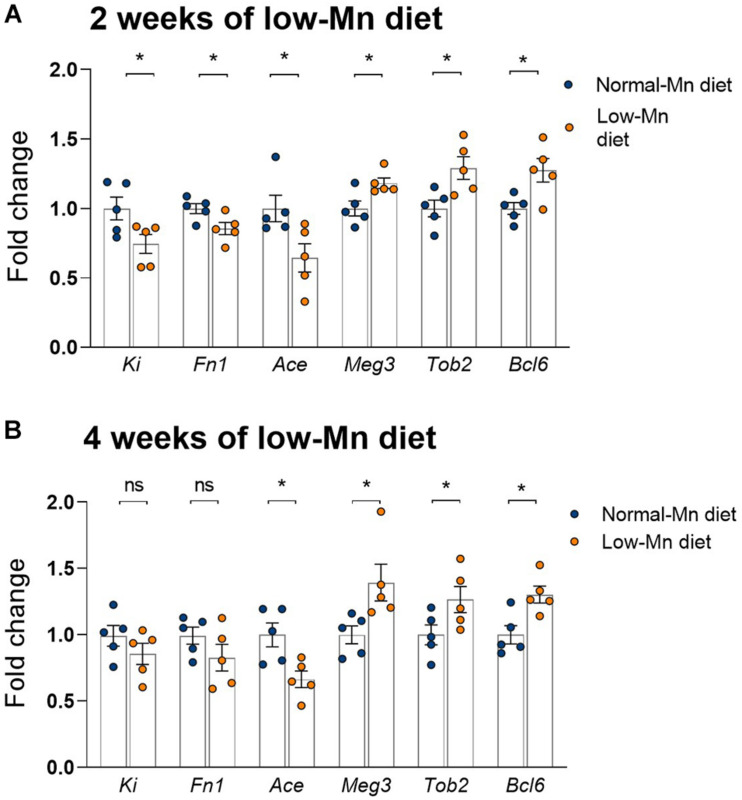
qPCR analysis of the cerebellum of mice fed for 2 or 4 weeks with a low-manganese (Mn) diet. (A) qPCR validation of Ki, Fn1, Ace, Meg3, Tob2, and Bcl6, six genes shown to be dysregulated in the RNA-seq analysis of the cerebellum of mice fed for 2 weeks with a low-Mn diet (n = 5 per group). (B) qPCR quantification of Ki, Fn1, Ace, Meg3, Tob2, and Bcl6 in the cerebellum of mice fed for 4 weeks with a low-Mn diet (n = 5 per group). Data represent means ± SEM. *P < 0.05.